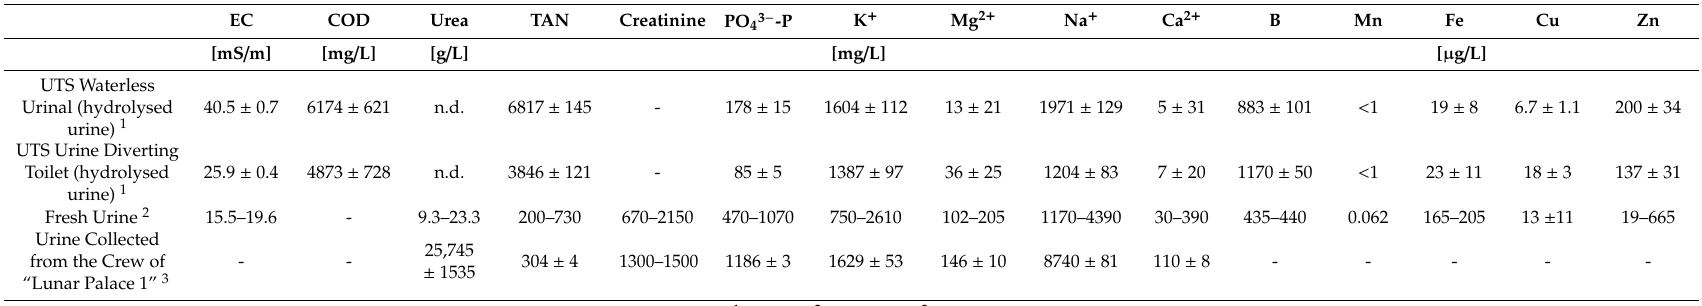
Table 1. Organic and inorganic chemical composition of human urine. The results from the first two rows are from the analysis conducted at the University of Technology Sydney (UTS) urine source separation system. The main di ff erence between waterless urinals and urine-diverting toilets is that, in the latter, urine gets diluted two to four times with tap water.